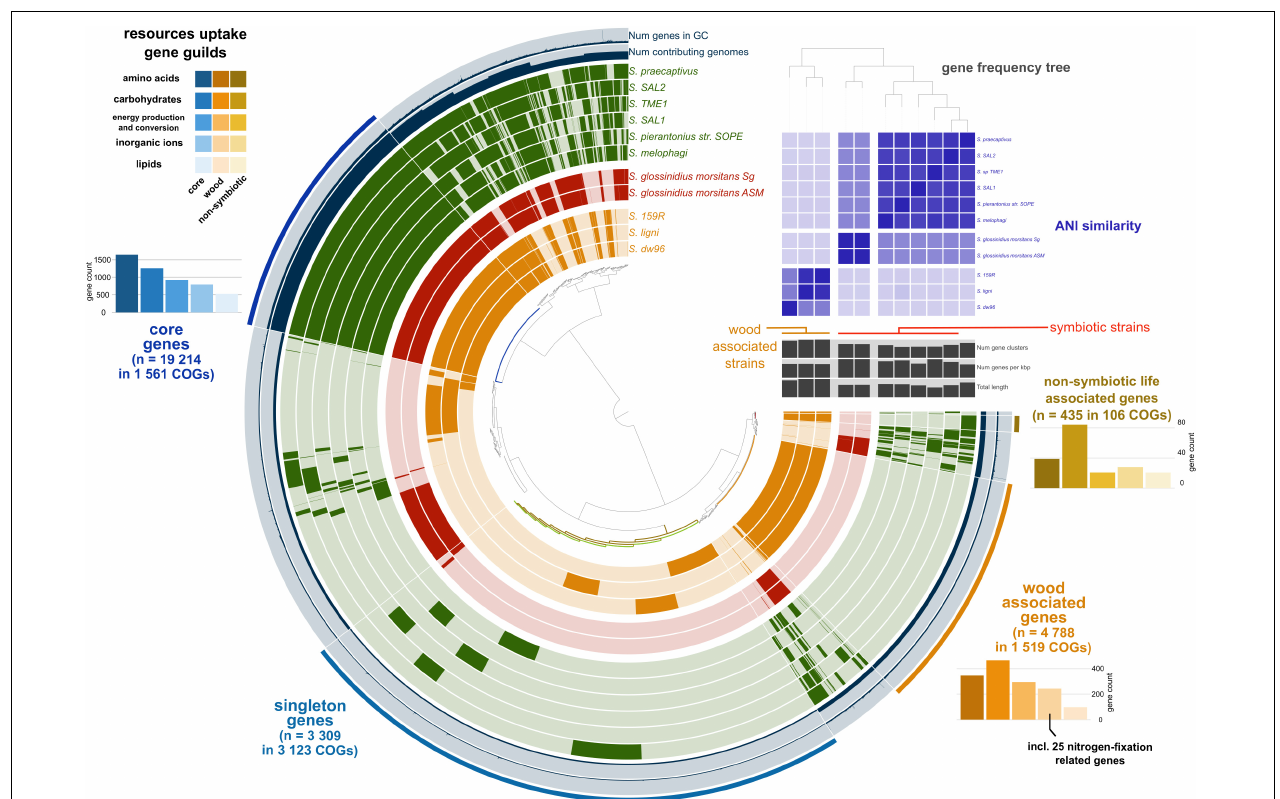
FIGURE 1 | Pangenome analysis of the available Sodalis genomes. Genes (indicated by dark colors within the circles) were clustered based on orthologous similarity (inner tree), and genome layers were sorted based on a gene frequency tree (right upper tree). Sodalis guilds are color coded; deadwood-associated strains in orange, tsetse fly symbionts in red and insect symbionts with S. praecaptivus in green. ANI is indicated as the upper right heatmap. Pangenome analysis identified core genes shared by all genomes (bar plots in hues of blue), genes associated with non-symbiotic life (bar plots in hues of yellow) and genes associated with wood habitat (bar plots in hues of orange). Individual bar plots show counts of genes divided according to their